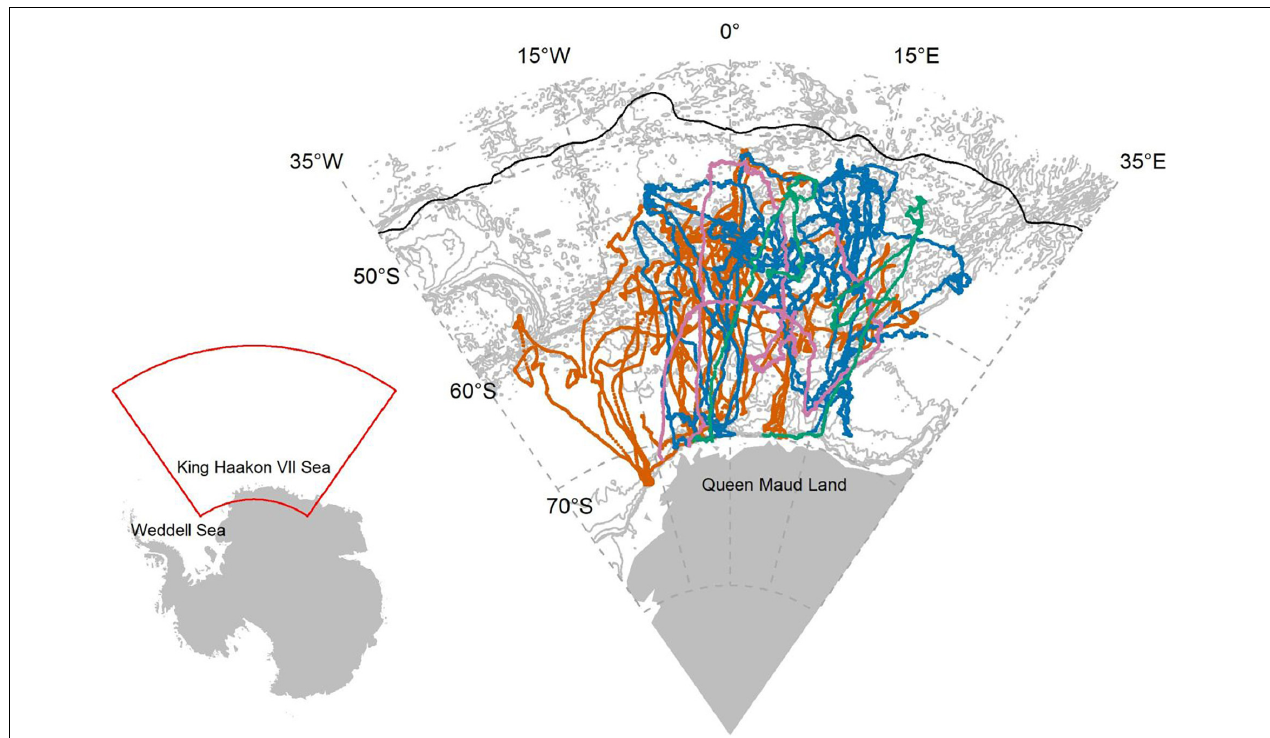
FIGURE 1 | State-space modelled location estimates for each of the 19 Ross seals in the King Haakon VII Sea that were used to model important foraging habitat in the Weddell Sea and surrounding areas. Colours represent the four different expeditions: orange: NARE 2000/01; blue: S55 2015/16; pink: PS111 2018; green: Scale 2019. The black line indicates the position of the Polar Front (Orsi et al., 1995) and the grey lines are GEBCO 1 arc-min bathymetrical contours (IOC et al., 2003). Inset: The position of this map in relation to the Antarctic continent.